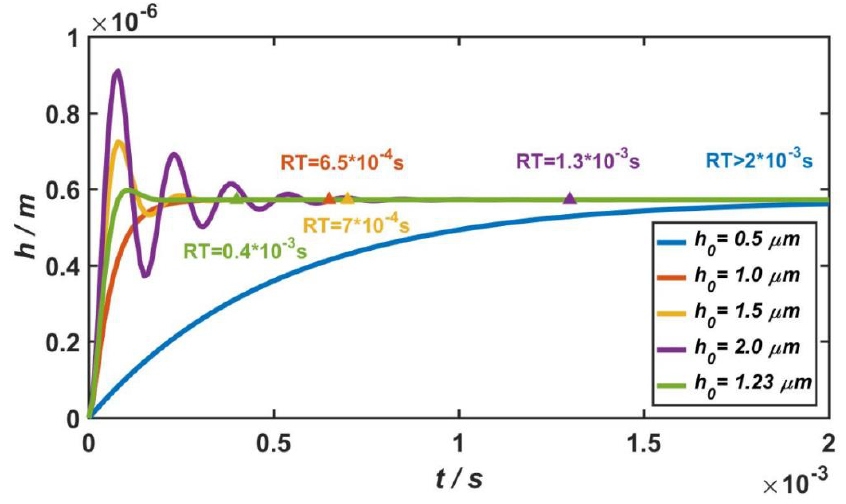
Figure 9. Step responses of the micro-accelerometer when the gap between the movable and fixed electrode plates ranges from 0.5 to 2 µm.